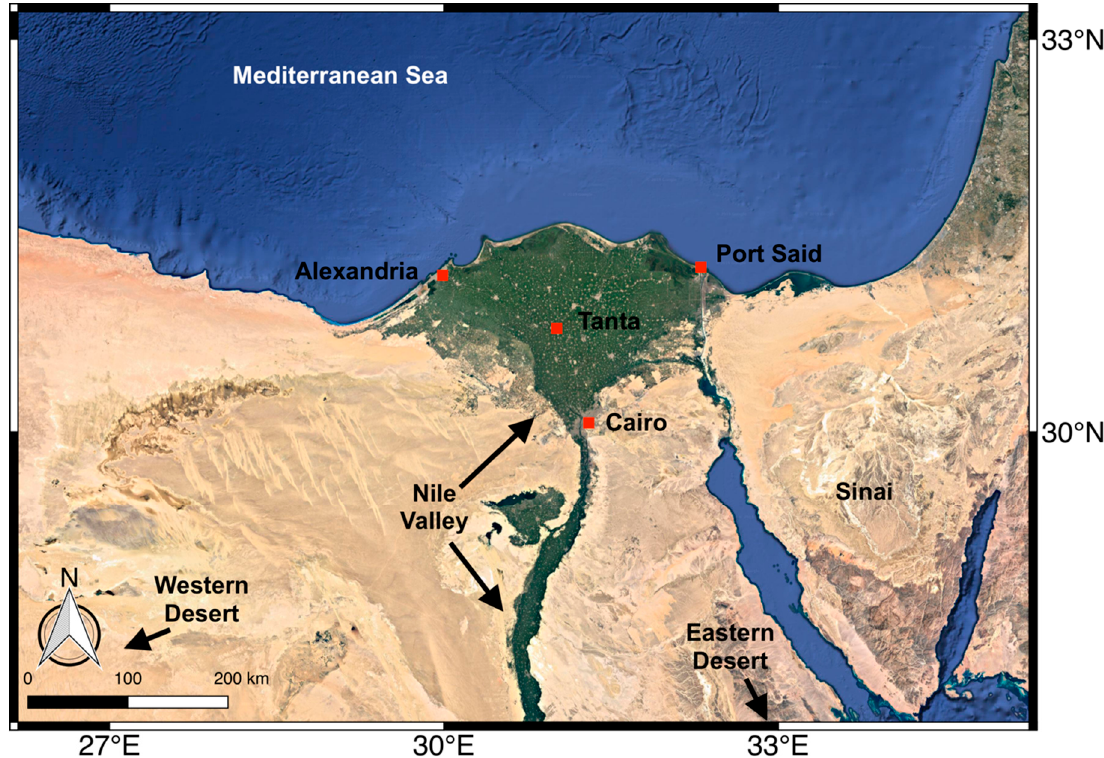
Figure 1. Nile Delta area of study and four main cities (Cairo, Alexandria, Tanta, and Port Said) in each Delta corner and center (background remotely sensed image from Google Earth).